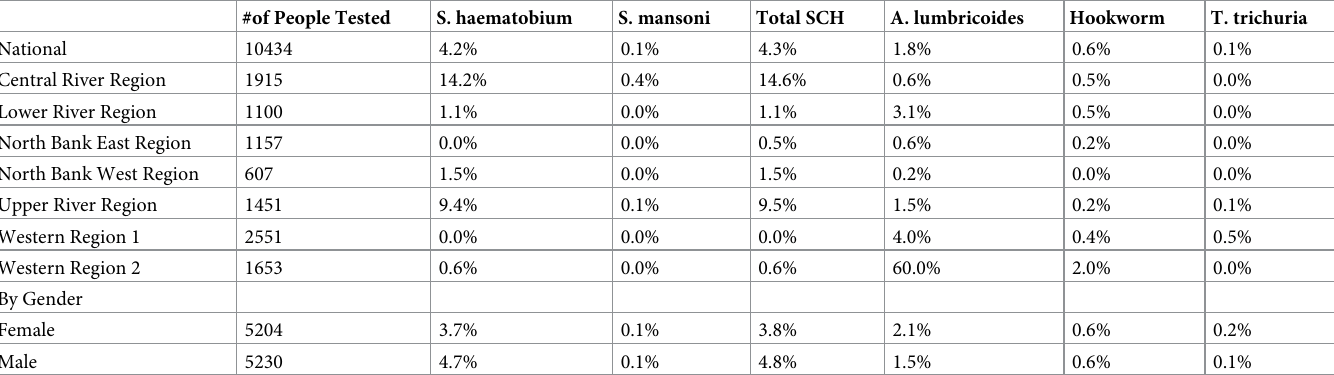
Table 2. Prevalence of Parasitic infection (%) among a cross section of school age children of 7–14 years across all Regions of The Gambia in May,